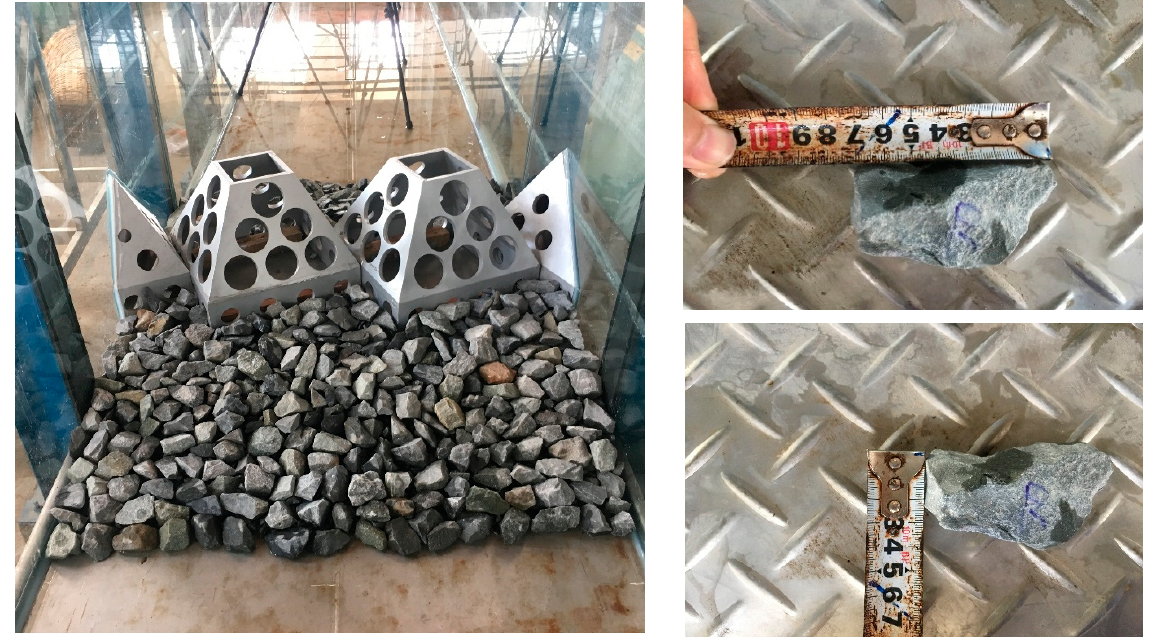
Figure 9. Design of stone revetment for scour protection.